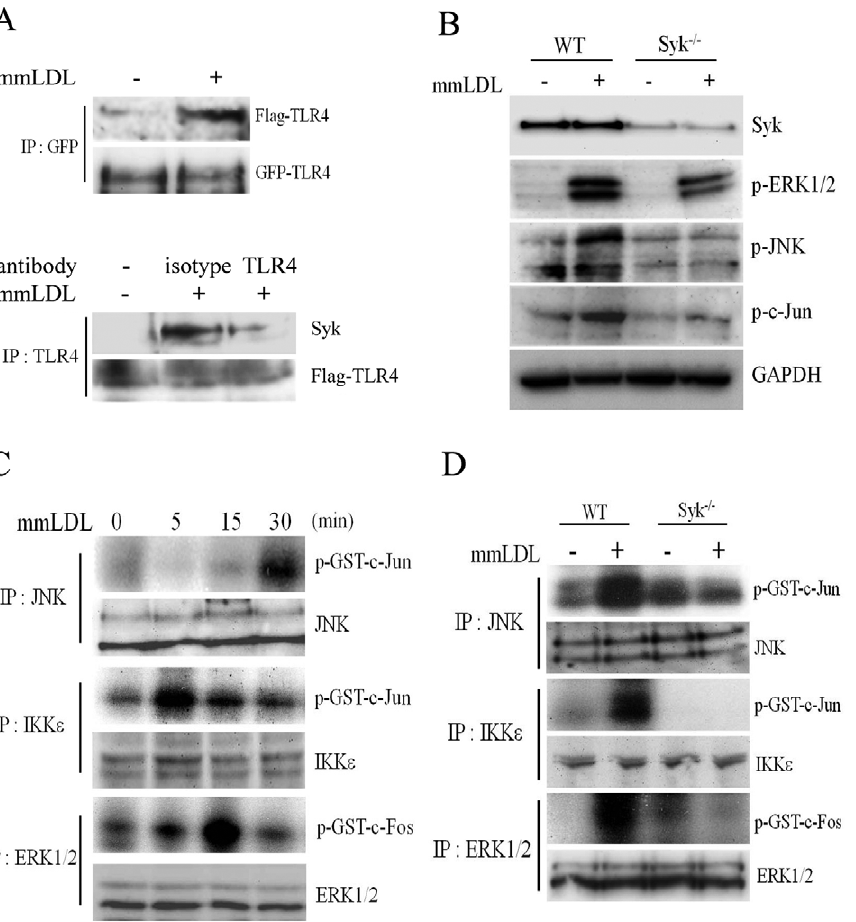
Figure 2. MAP kinases and transcription factors phosphorylation in WT and Syk 2 / 2 macrophages stimulated with mmLDL and KLA. ( A ) Upper blots: Ba/F3 cells stably expressing GFP-TLR4 and Flag-TLR4 were incubated with media or mmLDL (50 m g/ml) for 15 min. Cell lysates were immunoprecipitated with an anti-GFP antibody and immunoblotted with anti-Flag and anti-GFP antibodies. Lower blots: Ba/F3 cells were preincubated with 5 m g/ml of an anti-mouse TLR4/MD2 antibody (UT12) or an isotype IgG3 k control for 1 hour and then stimulated with mmLDL (50 m g/ml) for 15 min. Cell lysates were immunoprecipitated with a different anti-mouse TLR4 antibody (UT18) and immunoblotted with anti-Syk and anti-Flag antibodies. ( B ) WT and Syk 2 / 2 BMDM were incubated with media or mmLDL (50 m g/ml) for 15 min. Cell lysates were separated on SDS- PAGE and immunoblotted with antibodies against Syk, phospho-ERK1/2, phospho-c-Jun, phospho-JNK and GAPDH. ( C ) In vitro kinase assay in J774 macrophages. Cells were incubated with mmLDL (50 m g/ml) for indicated periods of time and then precipitated with anti-JNK, anti-IKK e and anti- ERK1/2 antibodies. Endogenous JNK and IKK e kinase activities were determined using GST-c-Jun (1–79 aa) as a substrate, and endogenous ERK1/2 kinase activity was determined using GST-c-Fos (300–380 aa) as a substrate. Protein levels of endogenous JNK, IKK e and ERK1/2 in the same cell lysates were determined by immunoblot. This experiment informed the optimal stimulation time periods for the experiment in panel D. ( D ) In vitro kinase assay in WT and Syk 2 / 2 BMDM. Cells were treated with media or mmLDL (50 m g/ml) for 30 min (JNK), 5 min (IKK e ) or 15 min (ERK1/2). Kinase activities were determined using the same method as in C.